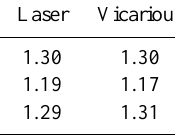
Fig. 14. Example of a matrix measurement using a laser beam with photometer #143 Table 7. Comparison of the field of view results (given in degrees) obtained using the Sun and a laser beam as a source.